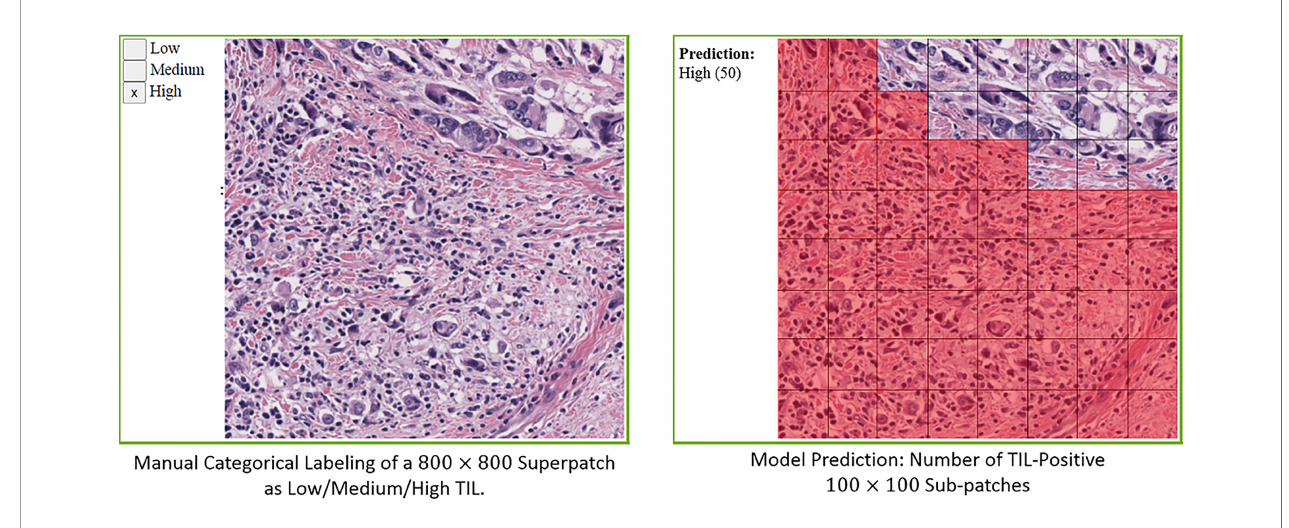
FIGURE 6 | Illustration of a superpatch labeling and prediction.